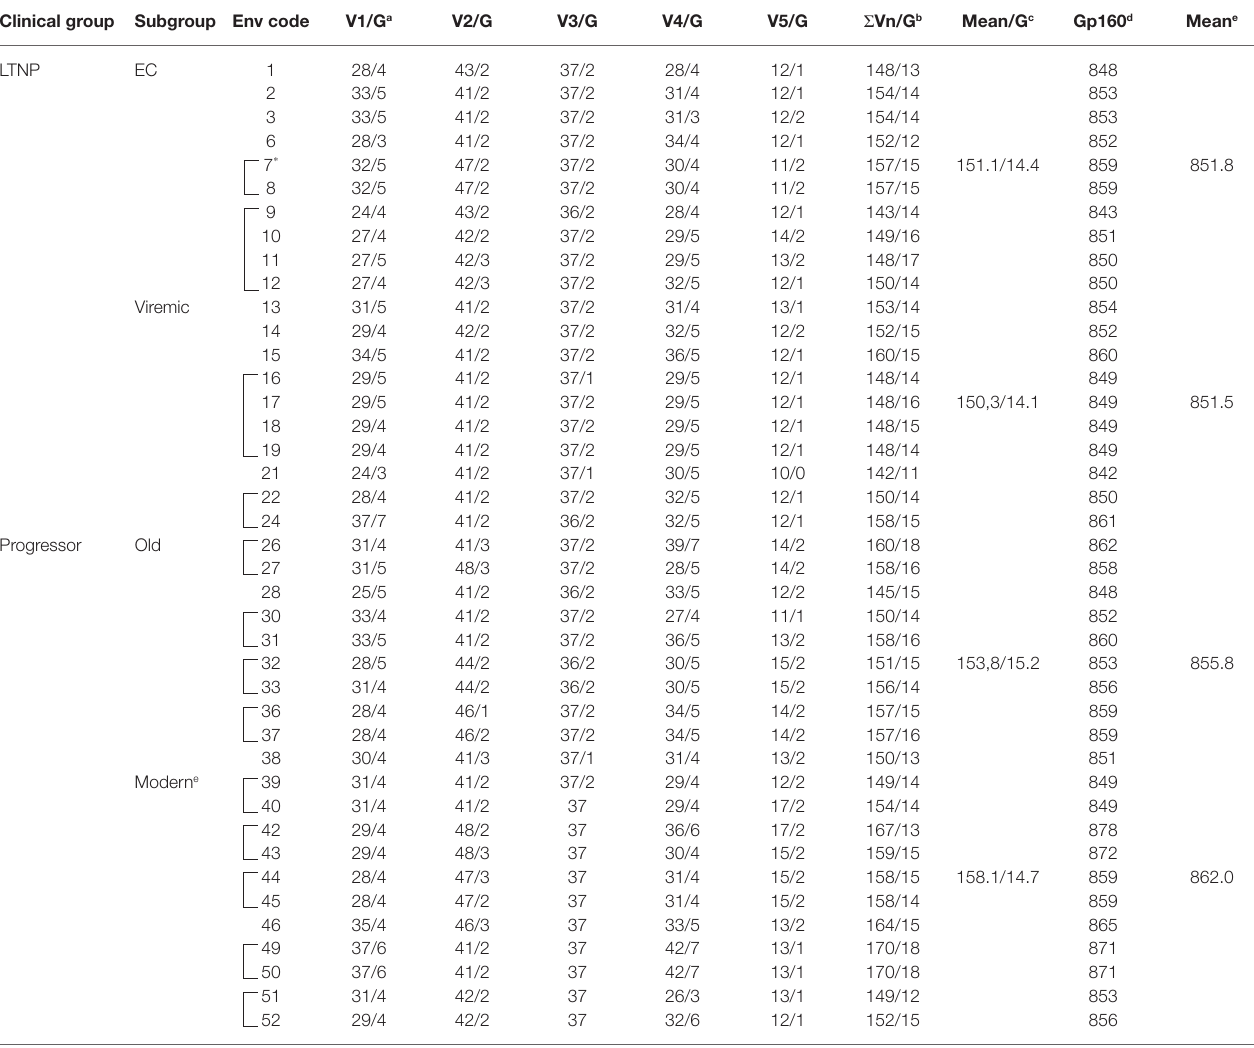
TABLE 2 | Molecular characteristics of HIV-1 Envs: sequence length and N potential glycosylation sites (PNGs) in the variable loops (Vn) of the gp120 subunit. Clinical group Subgroup Env